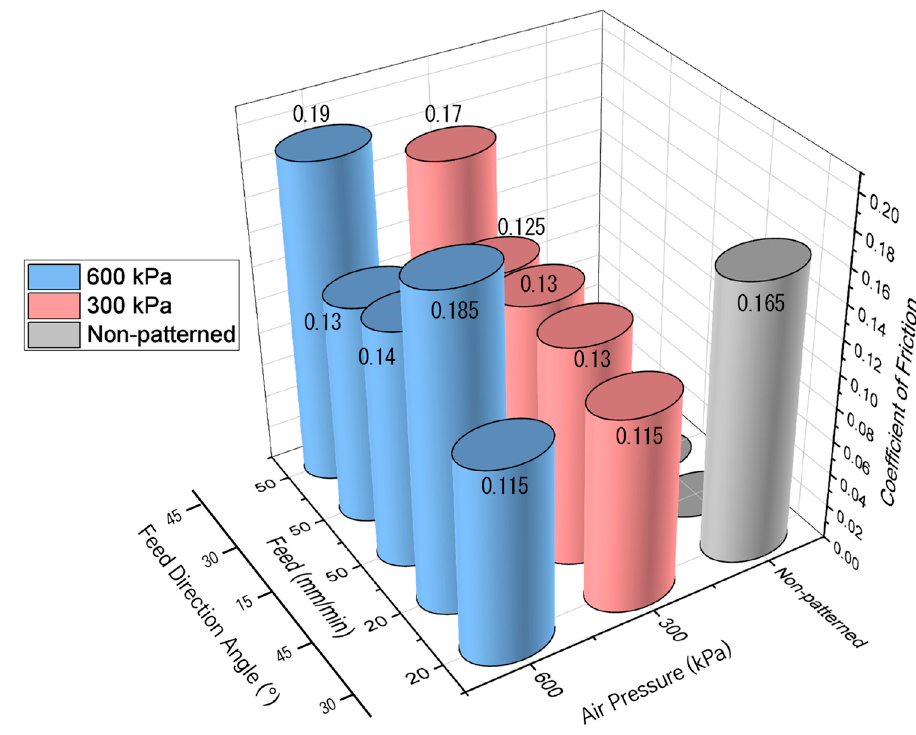
Figure 16. Coefficient of friction due to changes in the pressure of micro-AAJ at 200 Figure 16. C oe ffi cient of friction due to changes in the pressure of micro-AAJ at 200 rpm.